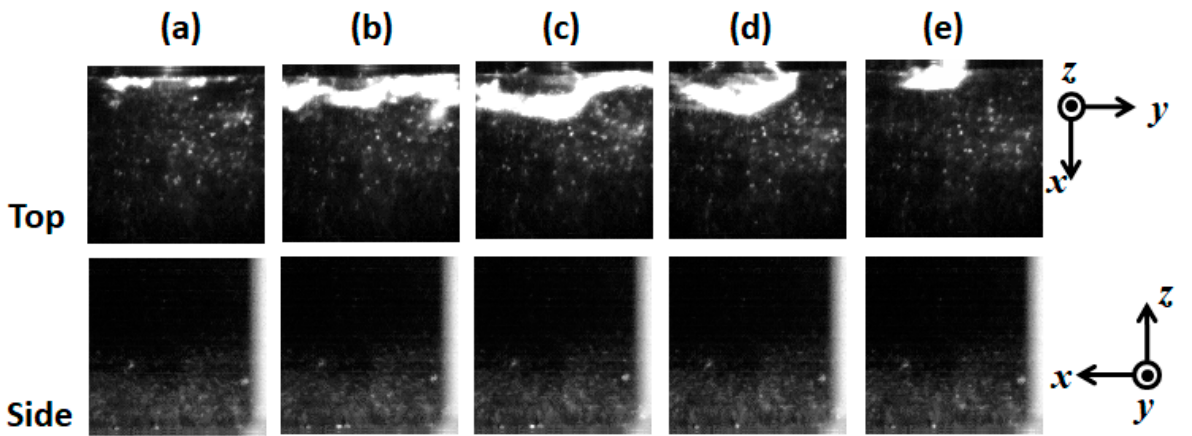
Figure 10. Instantaneous visualization using the synchronized signal with two high-speed cameras at a heat flux of 4.0 MW/m 2 : ( a ) 1006.2 ms, ( b ) 1006.6 ms, ( c ) 1006.9 ms, ( d ) 1007.2 ms, and ( e ) 1007.5 ms.